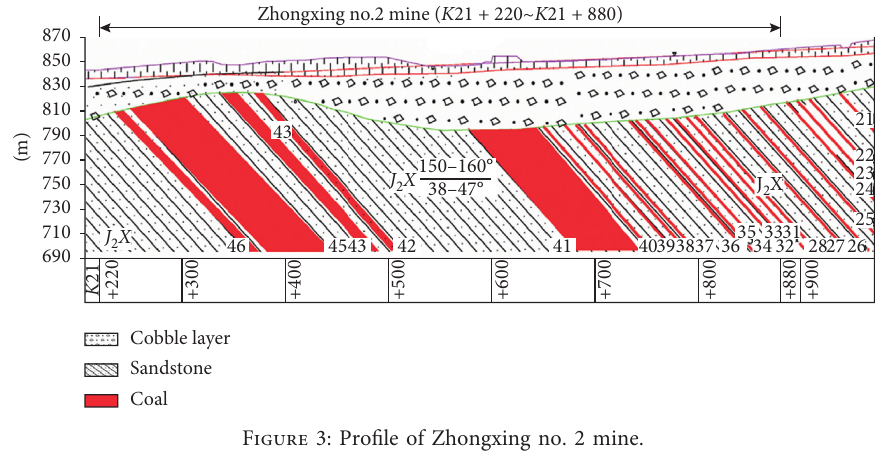
Figure 3: Profile of Zhongxing no. 2 mine.